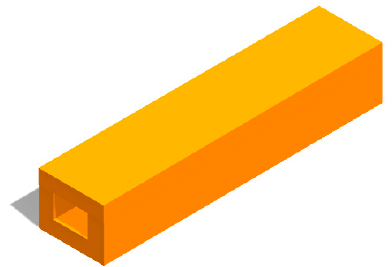
Figure 3. A complete electromagnetic transmission channel of a WR2.8 waveguide, consisting of a channel block and a copper plate cover.